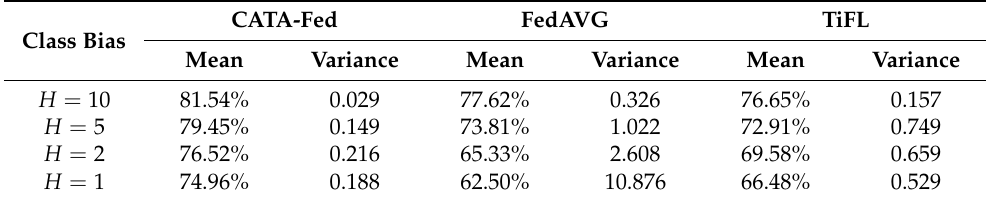
Figure 14. ( a ) Test set accuracy of CATA-Fed vs. global iterations, ( b ) test set accuracy of FedAVG vs. global iterations and ( c ) test set accuracy of TiFL vs. global iterations for CIFAR-10 under the condition of non-IID setting with class bias H = [ 1,2,5,10 ] , the number of cluster P = 4, and deadline T = 1. Table 4. Comparison of mean, variance of accuracy in CIFAR-10 according to the degree of class